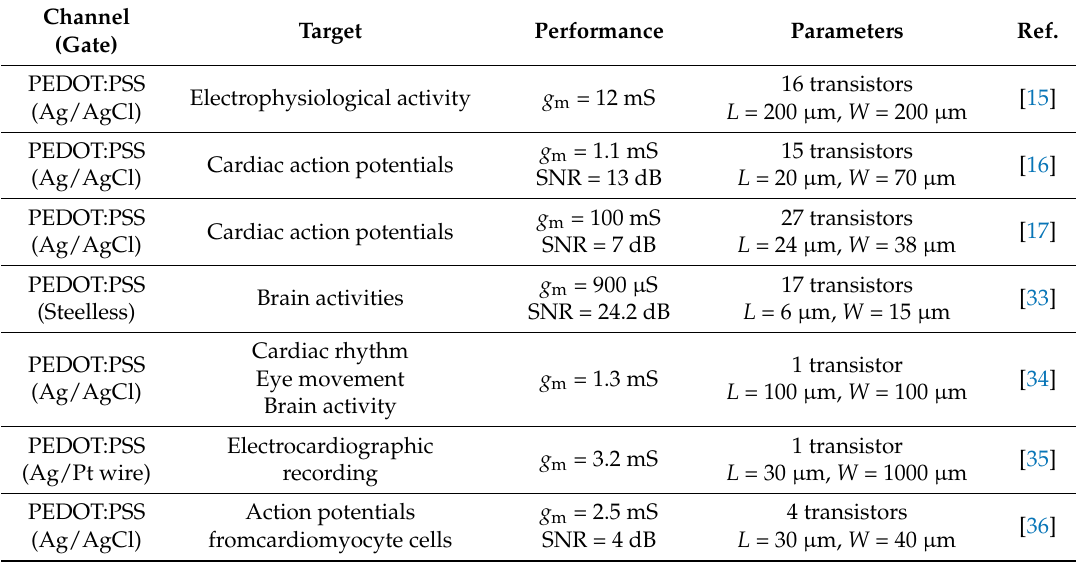
Table 1. Application of OECTs with high transconductance and excellent signal to noise ratio in monitoring bioelectric signals.